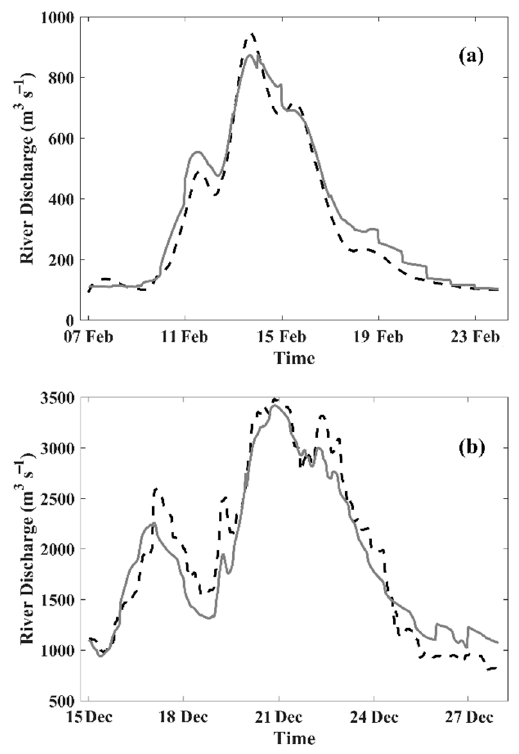
Figure 5. Forecasted (grey line) and measured (dotted black line) river flow for the most dangerous events occurred at ( a ) Lugo (2016) and ( b ) Ourense (2019) locations.